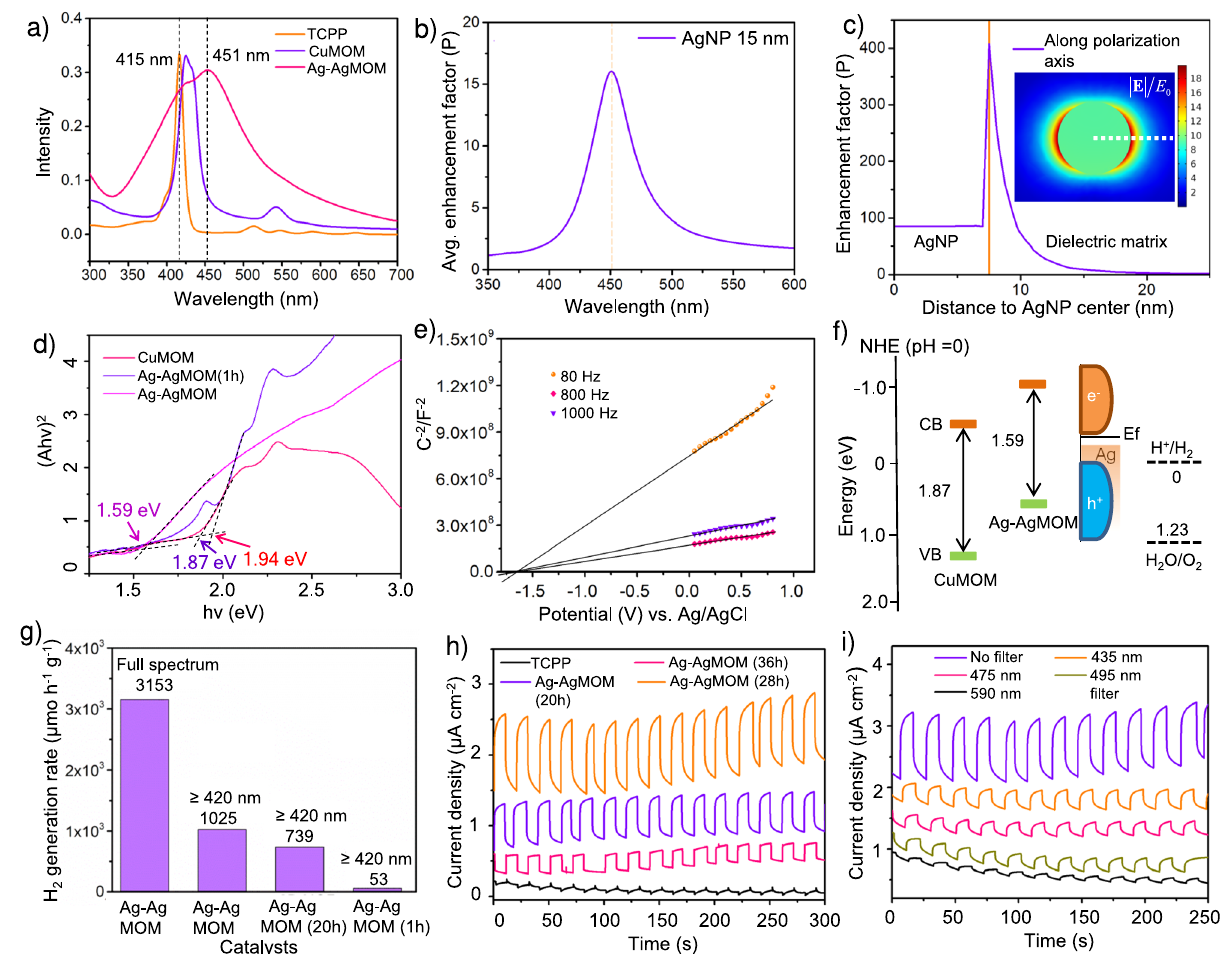
Fig. 2 | Optical and electronic properties and photocatalytic performance of Ag – AgMOM. a Ultraviolet-visible absorption spectra of Ag – AgMOM, tetrakis(4- carboxyphenyl)porphyrin (TCPP) and CuMOM in ethanol solution. b Simulation spectrum of the average enhancement factor in a shell surrounding the AgNP of 15nmindiameter,embeddedinMOF. c Enhancementfactoralongthepolarization axis,underaplanewaveexcitationwithawavelengthof 451.3nm.Inset:mapofthe normalized electric fi eld along a cross section ofthe Agnanoparticle(AgNP) atthe same wavelength. d The Tauc plots of CuMOM, Ag – AgMOM and Ag – AgMOM(1h). e Mott – Schottky plots of Ag – AgMOM under different frequencies. f Energy